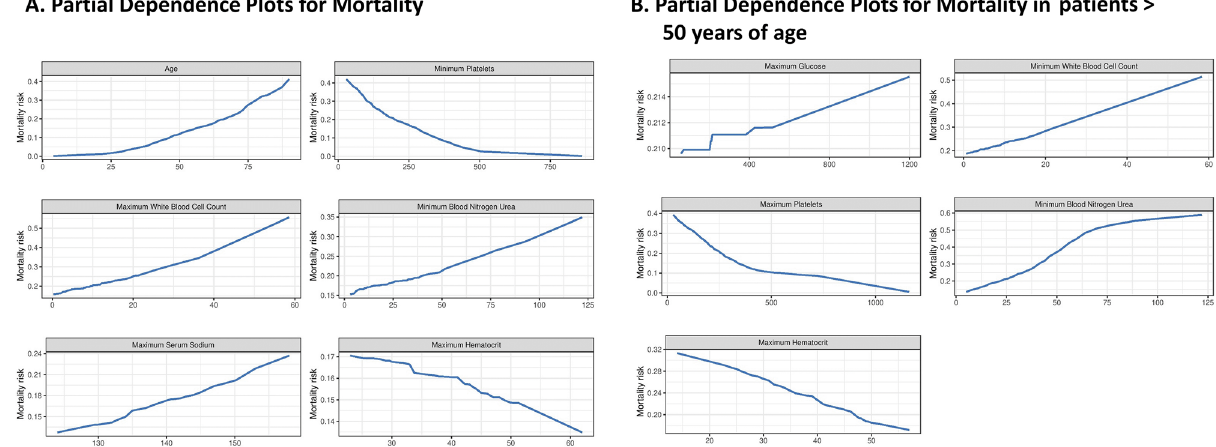
Figure 3. Partial dependence plots for mortality prediction model illustrating the relationship between mortality and the six top predictor variables A. Risk of mortality increases with increasing age, platelets < 500 10 9 /L, and increasing white blood cell count. Risk of mortality increases with increasing blood urea nitrogen with an inflection point at 50 mg/dL. The risk of mortality increases with decreasing haematocrit levels and increasing sodium levels. B. Risk of mortality increases with increasing age, platelets < 500 10 9 /L, and increasing white blood cell count. Risk of mortality increases with increasing blood urea nitrogen until 75 mg/dL and then levels off. The risk of mortality increases with decreasing haematocrit levels.